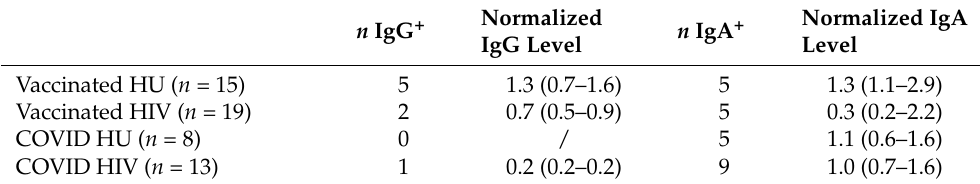
Table 8. Normalized saliva anti-spike IgG and IgA